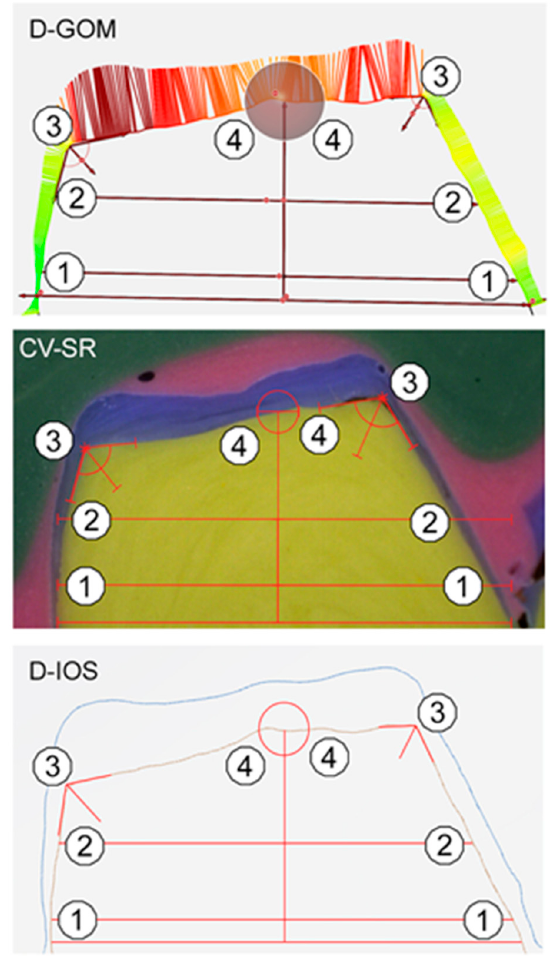
Figure 3. Example of the three evaluation methods (D-GOM = digital replica method with laboratory software, CV-SR = conventional silicone replica technique and D-IOS = IOS-based digital approach): 1 = marginal fit, 2 = axial fit, 3 = occlusal fit.